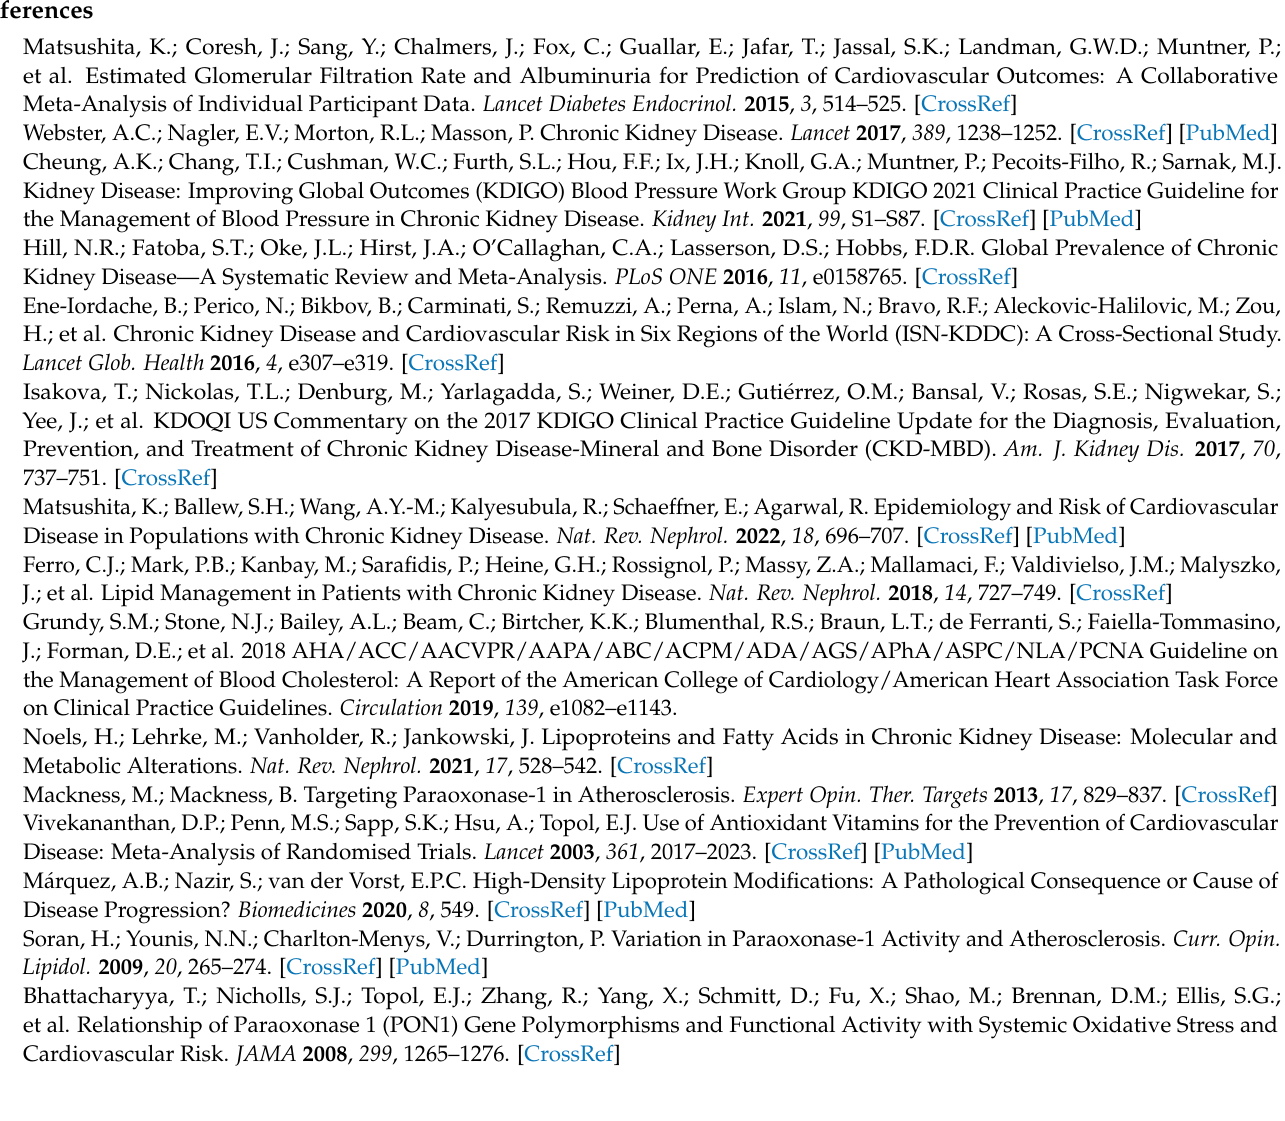
Figure A9. Funnel plot of arylesterase activity (Egger test > 0.05).